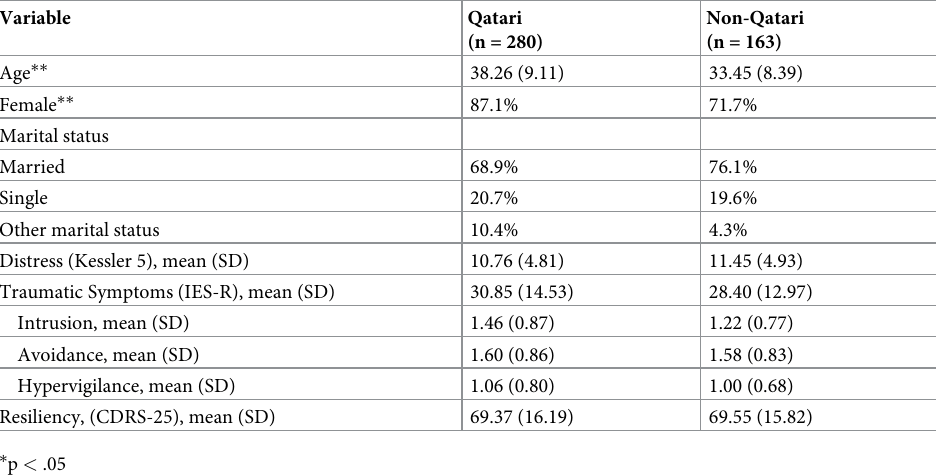
Table 4. Demographic and mental health scales by Qatari citizenship (n = 443). Demographic and mental health scales by Qatari citizenship with sample size 443 (280 Qatari, 163